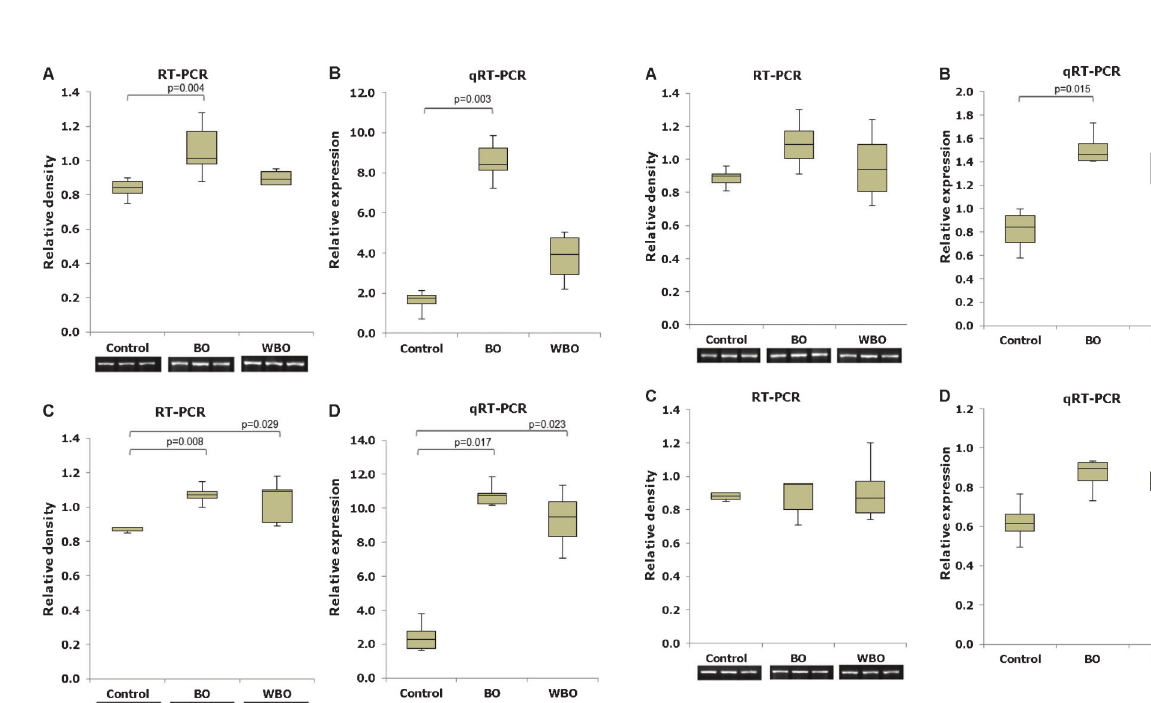
Figure 4. Gene expression profile of TGF- b 1 from control rats, BO and WBO parenchymas. A , C , Semiquantitative analysis (RT- PCR) of the relative density at 7 days ( A ) and 60 days ( C ) after selective ligation of the bile duct. B , D , Quantitative analysis (qRT-PCR) at 7 days ( B ) and 60 days ( D ) after selective ligation of the bile duct. The gene expression values were obtained by relative quantification using the 2 - DD ct method. One-way ANOVA was used for the statistical